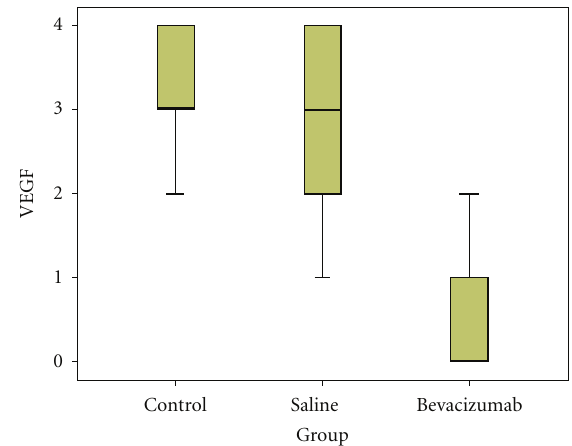
Figure 5: The bevacizumab group had a significantly lower staining with VEGF immunohistochemical